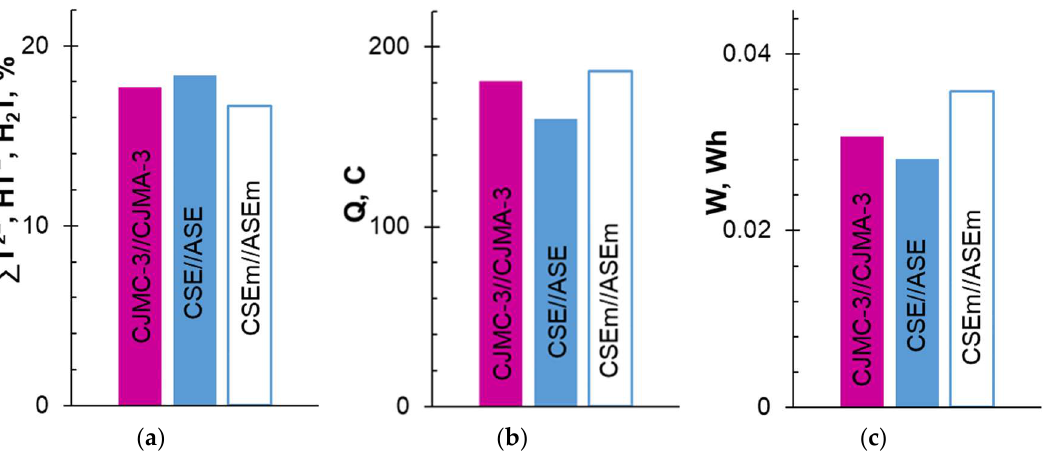
Figure 3. The degree of removal of tartrates ( a ), the number of electric charges transported ( a ) and energy consumption ( b ) with a decrease in the conductivity of the model solution in the desalination circuit by 20%. The data are presented for CC 1 , DC and CC 2 formed by CJMC-3 and CJMA-3, CSE and ASE, and CSEm and ASEm membranes.